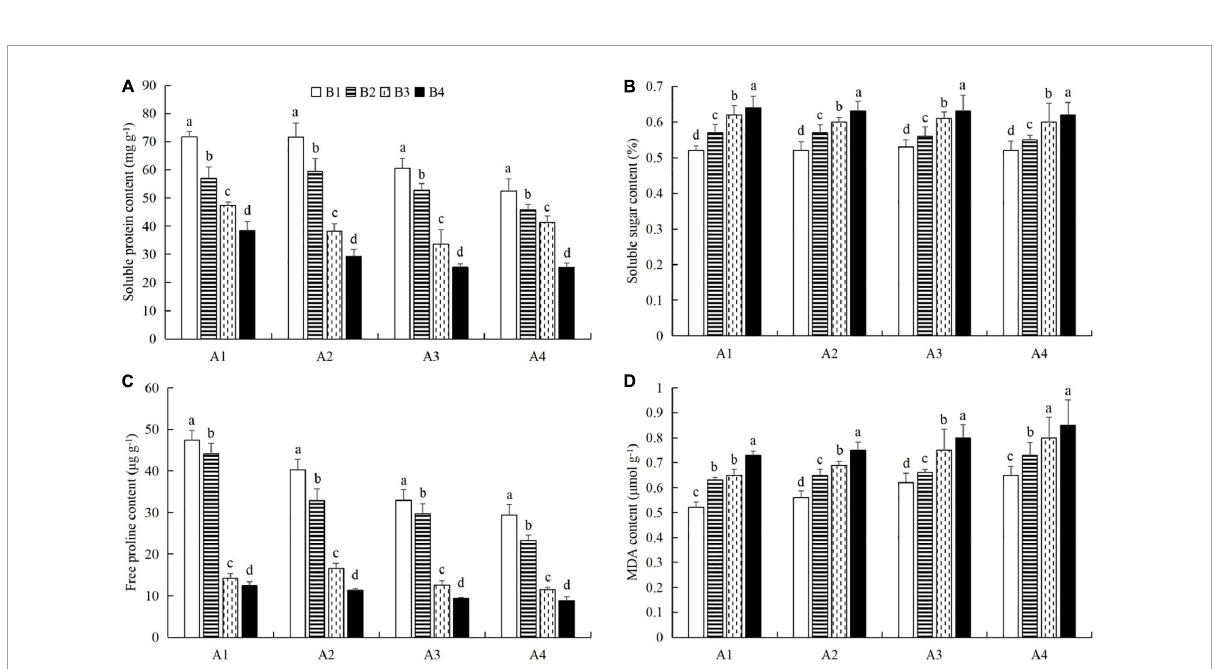
FIGURE10 The effects of imidacloprid on the contents of (A) soluble proteins, (B) soluble sugars, (C) free proline, and (D) malondialdehyde (MDA) in cucumber leaves at different azoxystrobin concentrations. Azoxystrobin concentrations: 4 mg L − 1 (A1), 2 mg L − 1 (A2), 1 mg L − 1 (A3), and 0 mg L − 1 (A4). Imidacloprid concentrations: 750 mg L − 1 (B1), 500 mg L − 1 (B2), 250 mg L − 1 (B3), and 0 mg L − 1 (A4). The mean value ± p < 0.05 error bar data were presented in the figure and different alphabetical letters indicate the significant differences between the different imidacloprid